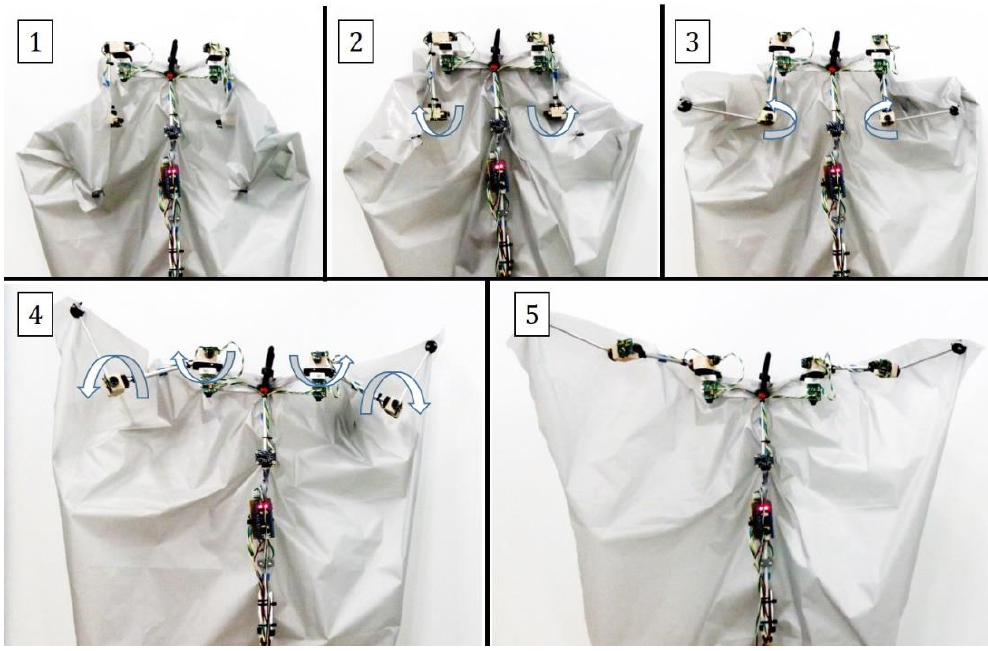
Figure 12. Sequence of rotations for unfolding the wings: arms stretched ( 1 ), elbow ( 2 ), shoulder yaw ( 3 ), shoulder pitch and elbow pitch ( 4 ) joint rotations, flying / gliding pose ( 5 ).